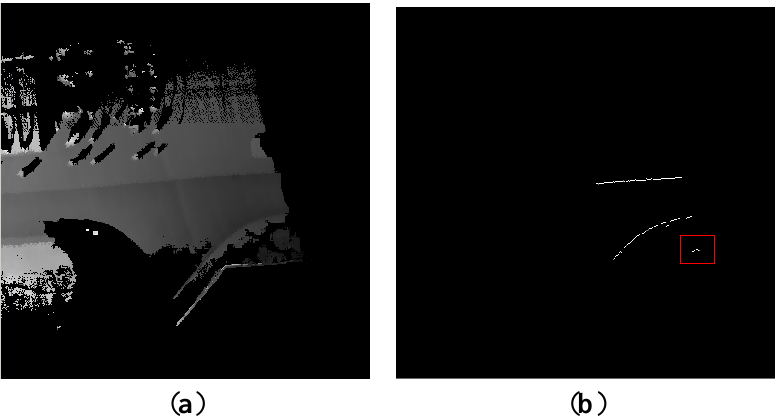
Figure 5. The results of the curb candidate detection. ( a ) The local DEM. ( b ) The curb candidate points in the local